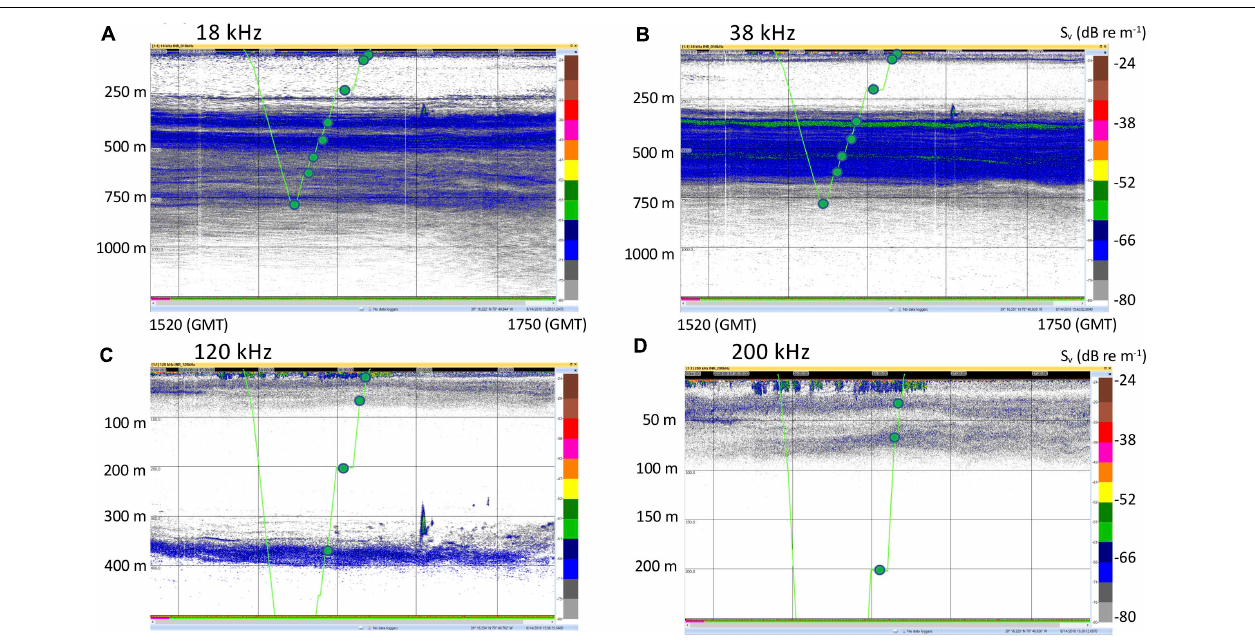
FIGURE 2 | Representative echosounder images with noise reduction applied, and the CTD track and sampling locations overlain in green. (A) 18 kHz. (B) 38 kHz. (C) 120 kHz. (D) 200 kHz. These images are for Cast 5 on 14 August 2018. Images for the rest of the casts are in Supplementary Figures S1–S4 . Time stamps (GMT) indicate the start and end of the echograms and vertical bars are at 30 min intervals. Note change of vertical scale for the 120 kHz (500 m) and 200 kHz (250 m) echograms.